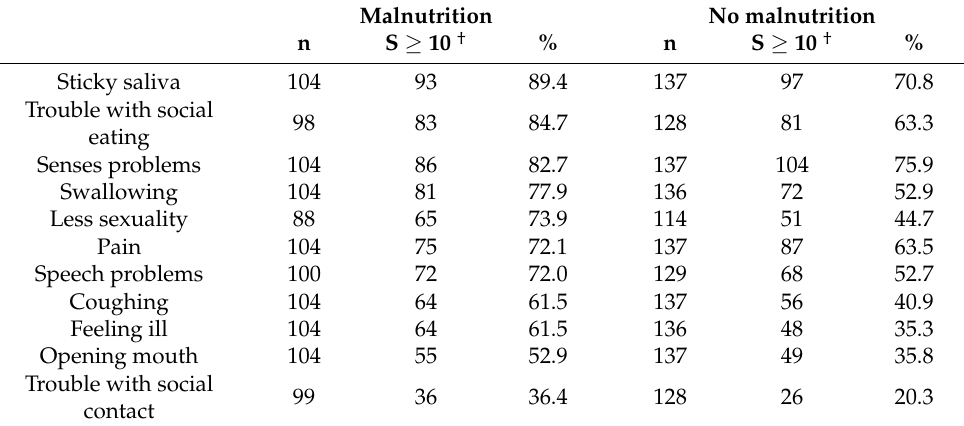
Table 3. Clinically relevant deterioration from the start of treatment to seven weeks the after start of treatment in a number of EORTC QLQ-H&N35 scales proven to be significantly different between patients with malnutrition defined by the Global Leadership Initiative on Malnutrition (GLIM) and patients without malnutrition.